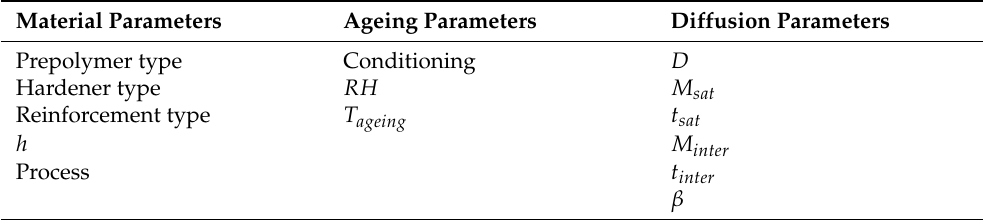
Table 8. List of variables used in the principal component analysis. The 8 qualitative variables are in italics and the 4 quantitative variables in